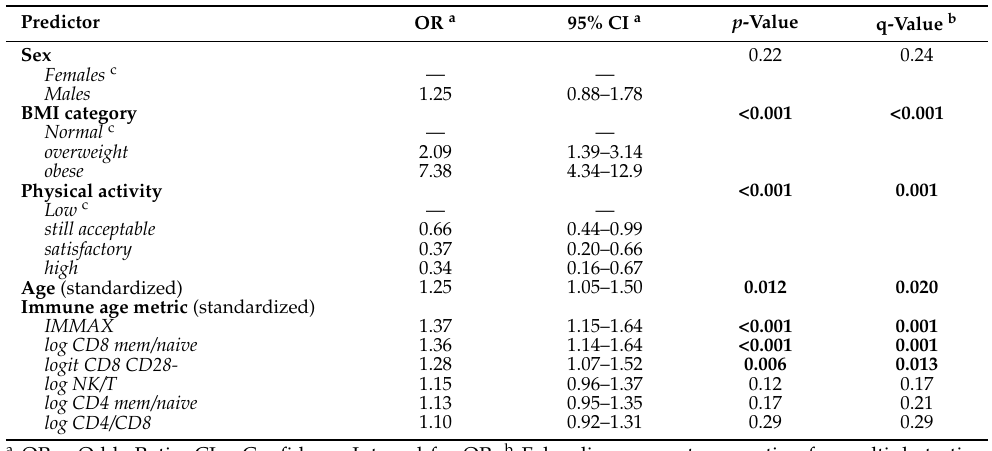
Figure 2. Bivariate associations of low cardiorespiratory fitness (CRF) with ( A ) categorical and ( B ) continuous predictors for the subsample of 547 complete observations from the DVS with 199 low CRF events. Table 2. Bivariate associations assessed by odds ratios from univariate logistic regression models predicting the probability of low CRF by sex, obesity (BMI category), level of regular physical activity, and by chronological age and six immune age metrics. The continuous predictors had been z-standardized to zero mean and unit variance prior to analysis, which was performed for the subsample of 547 complete observations with 199 low CRF